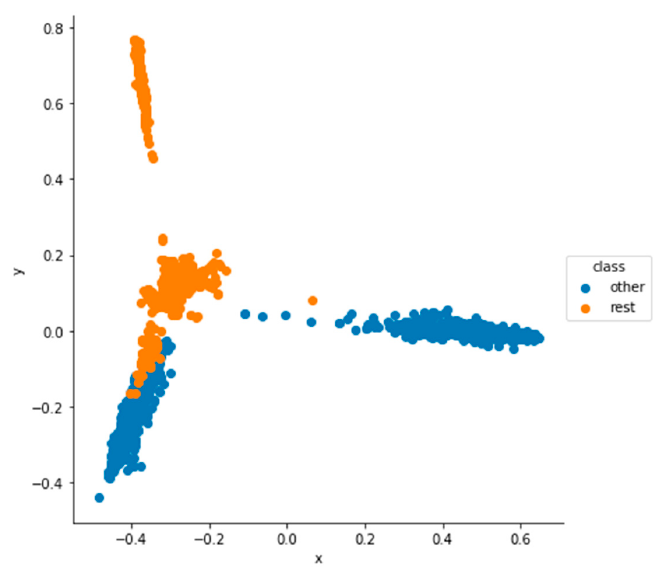
Figure 6. Result without the FPSR method.